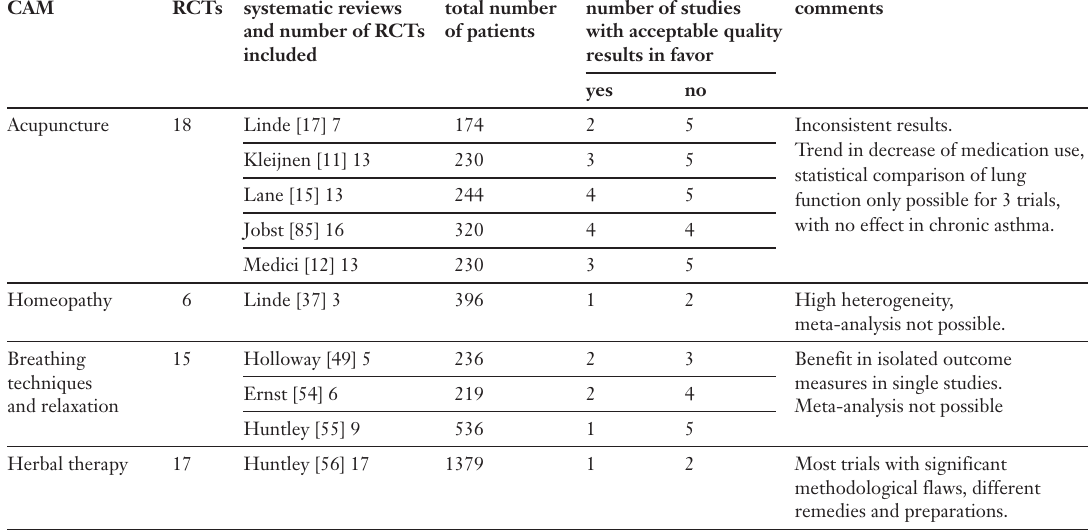
Overview of the pub- lished evidence for popular complemen- tary and alternative medicine (CAM) in